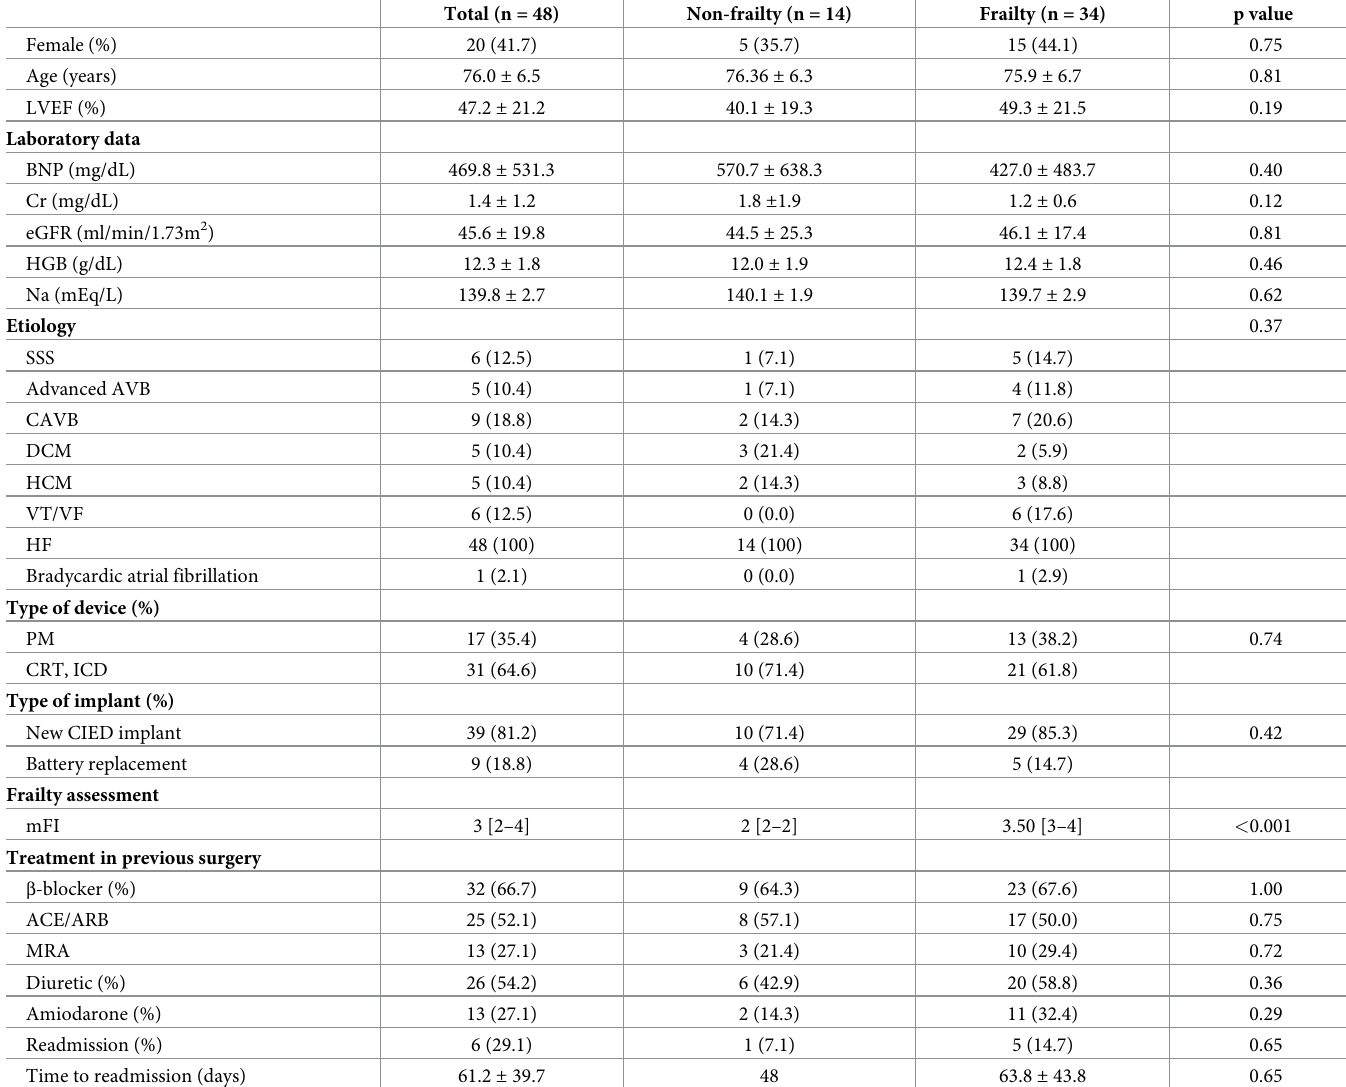
Table 4. Characteristics of participants with heart